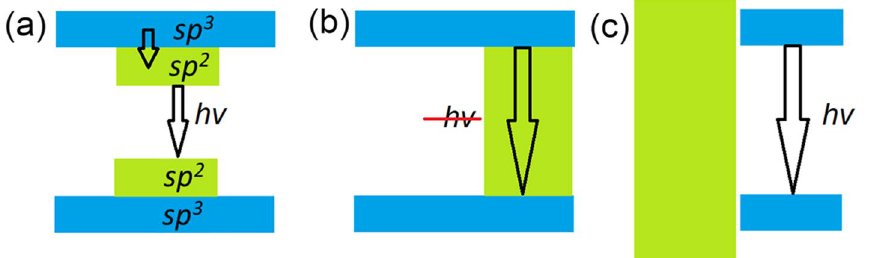
Scheme 1. Band diagrams and possible pathways of electron-hole recombination for the cases of: a sp 2 -hybridised area incorporated in the sp 3 -hybridised matrix a with a bandgap and b without a bandgap; and c a separate sp 3 -hybridised region at the edge of a gapless sp 2 - hybridised region. Examples of realistic structures corresponding to each scheme are discussed in